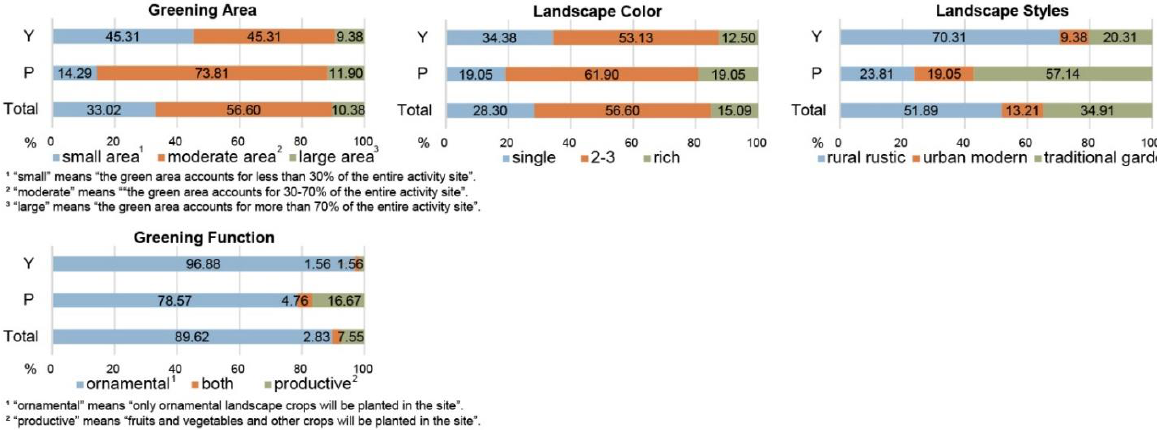
Figure 6. Survey statistics of respondents ’ landscape preferences.